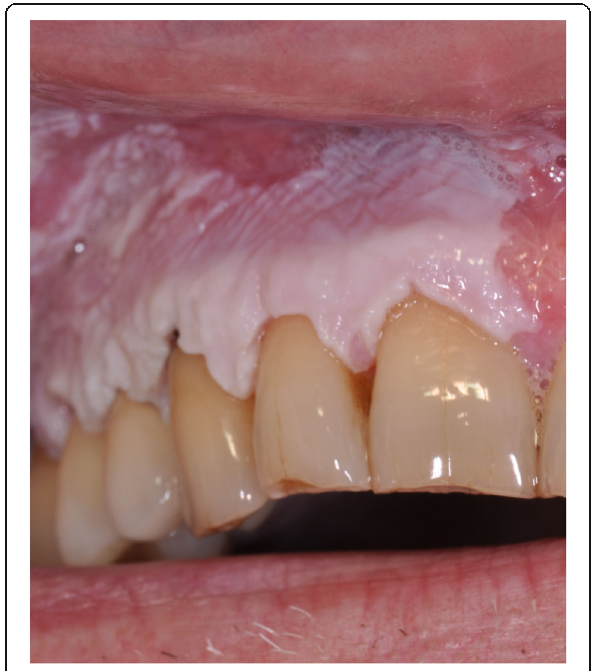
Fig. 1 Verrucous hyperkeratosis in the right maxillary gingiva at the